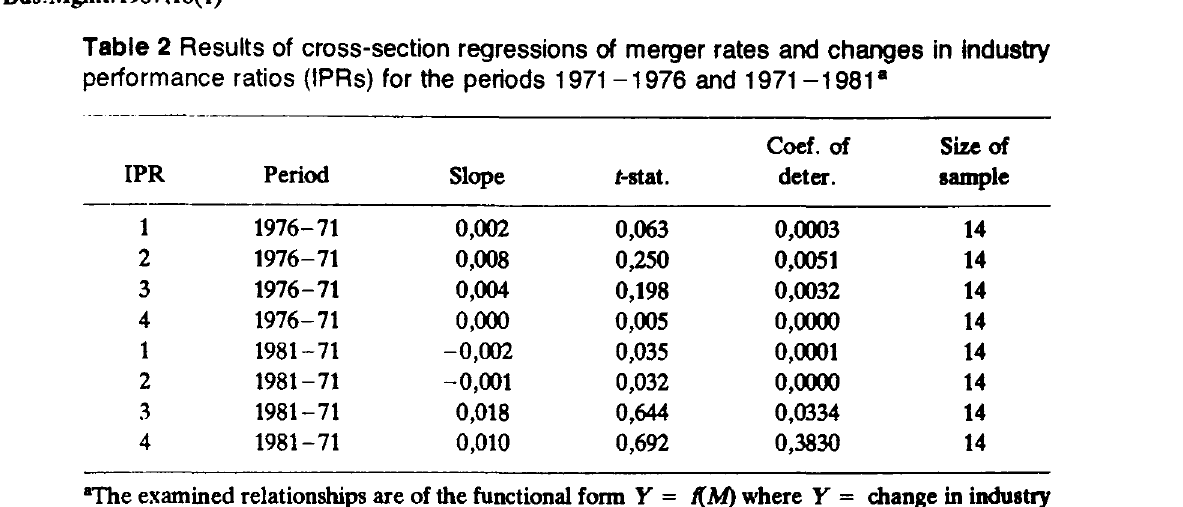
Table 2 Results of cross-section regressions ot merger rates and changes in Industry performance ratios (IPRs) for the periods 1971 -1976 and 1971 -1981 • ·--·---------- Period Slope